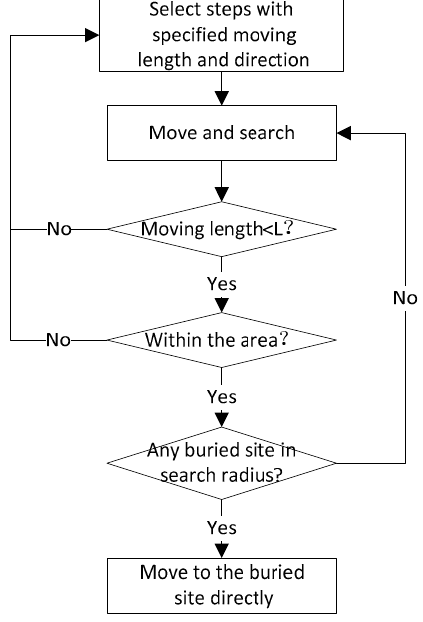
Figure 3. Searching plan of rescue teams.